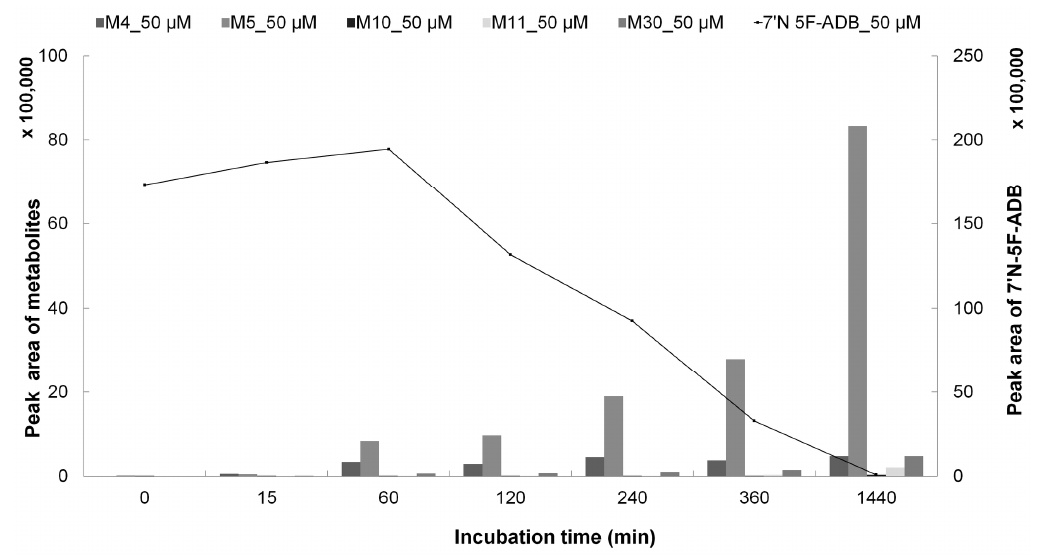
Figure 8. Internal amount-time profile of five main metabolites (M4, M5, M10, M11, and M30) in HepaRG cells incubated with 50 µ M 7 (cid:48) N -5F-ADB ( n =